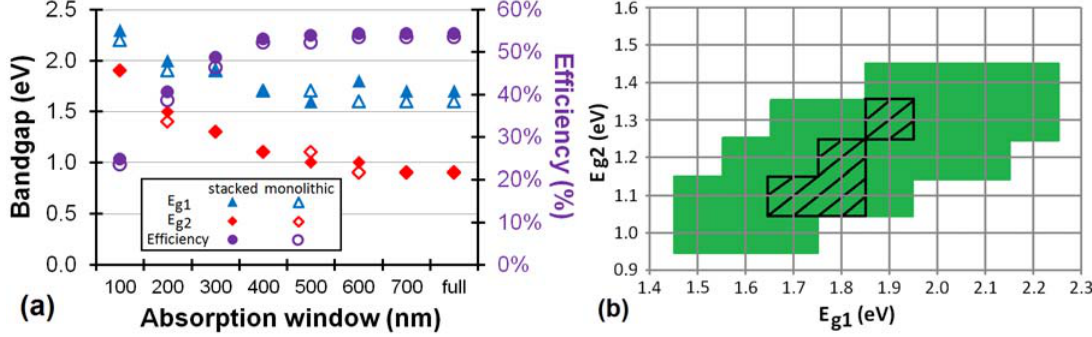
Figure 7. ( a ) The maximum efficiency is plotted in the ideal scenario (with  LUMO = 0.2 eV) for an organic stacked and monolithic tandem cell as a function of the absorption and E for a stacked cell are plotted as a function window. Also the optimum bandgaps E g1 g2 and E for the monolithic cell are of the absorption window. The optimum bandgaps E g1 g2 plotted if they differ from the stacked cell; ( b ) The green region and the black hatched region define the range of sufficient bandgap combinations (>90% of the maximum efficiency) of respectively a stacked and a monolithic organic tandem cell with absorption windows of 400 nm for the